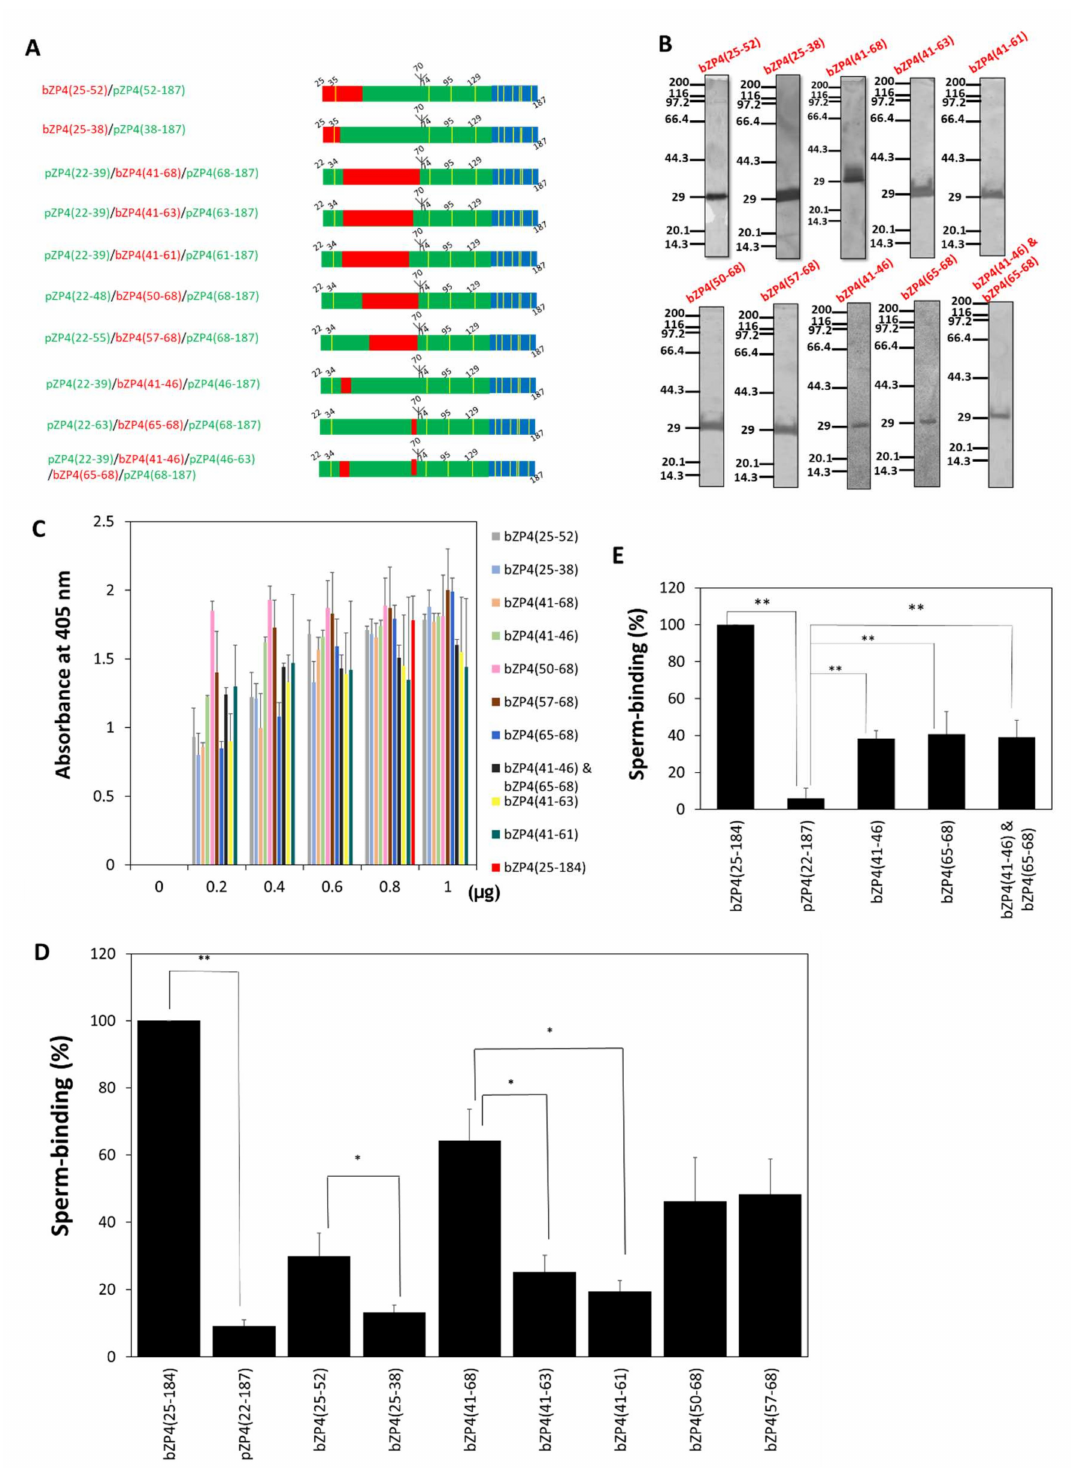
Figure 3. Two sites in the N-terminal half of the ZP-N1 domain of bZP4 are involved in the sperm- binding activity. ( A ) Schematic of bovine (red) and porcine (green) chimeric proteins in which bovine ZP4 (25–52), ZP4 (25–38), ZP4 (41–68), ZP4 (41–63), ZP4 (41–61), ZP4 (50–68), ZP4 (57–68), ZP4(41–46), bZP4(65–68) and both ZP4 (41–46) and ZP4 (65–68) replace the corresponding porcine sequences. The trefoil domain from pZP4 is shown in blue and Cys residues are in yellow bars. ( B ) SDS-PAGE of chimeric ZP4 proteins shown in ( A ). The proteins are represented in ( B – E ) by the bovine sequence regions shown in red in ( A ). The chimeric proteins were expressed in Sf9 cells and purified by